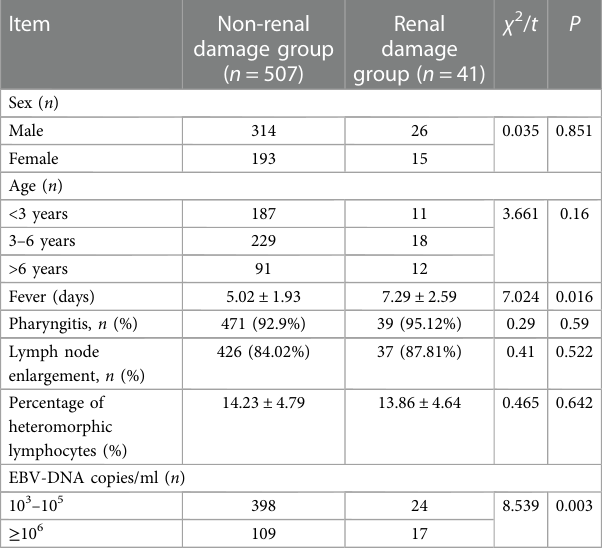
TABLE 2 Comparison of clinical data between the non-renal damage and renal damage groups.